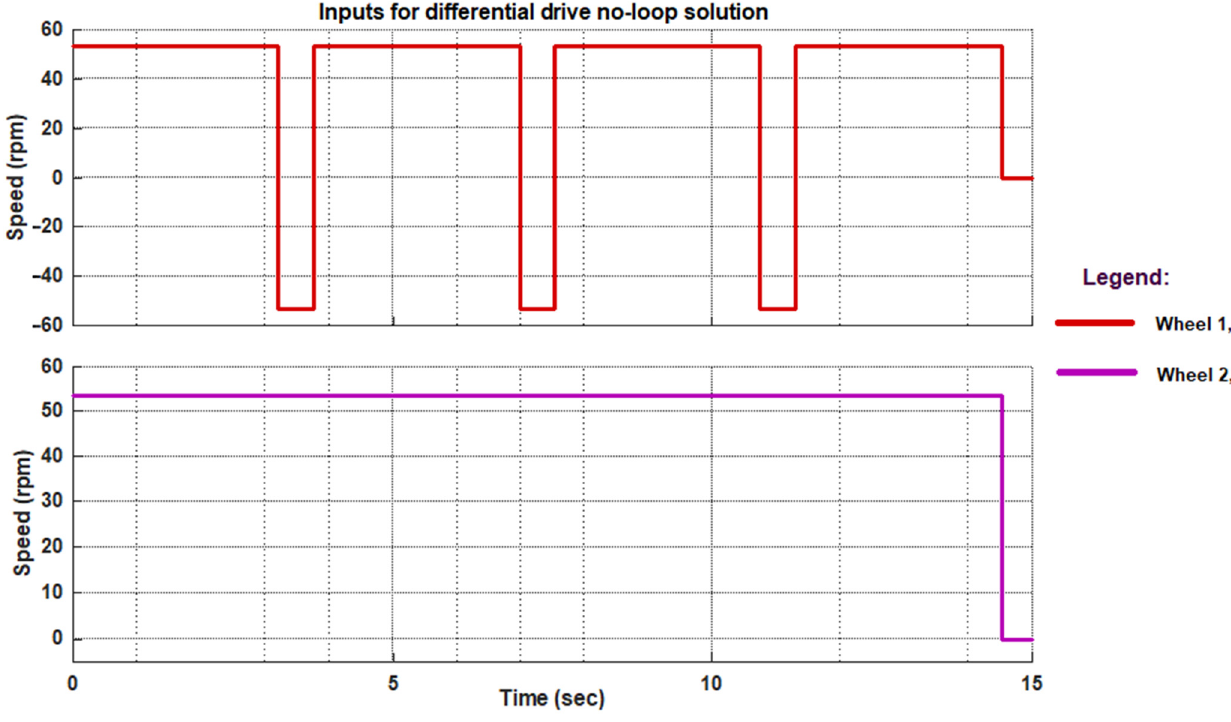
Figure 9. Inputs for the differential drive no-loop kinematic solution (speed of the wheels).